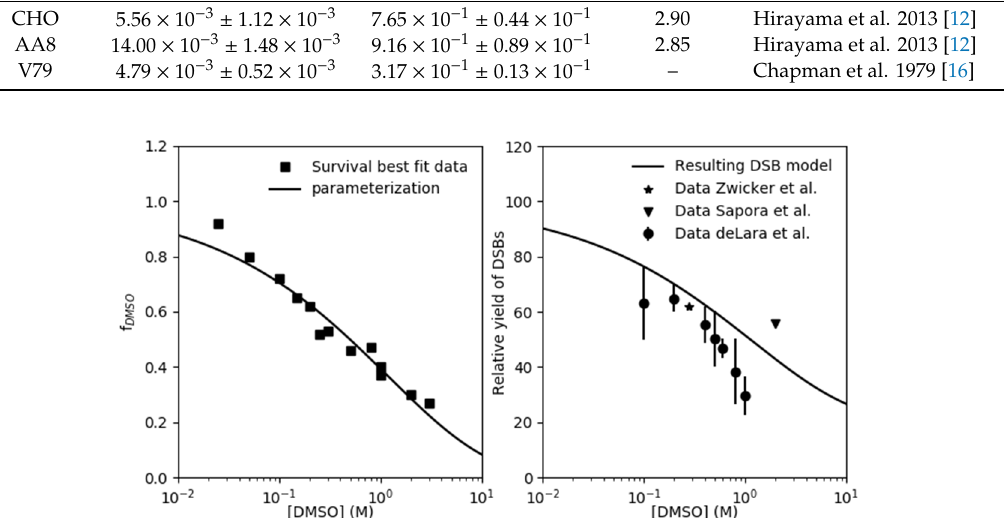
Figure 1. Left panel: f DSMO parameterization as function of DMSO in units of M is depicted with line together with best-fit f DSMO data (squares) obtained by reproducing the cell survival data in normoxia. Right panel: predicted initial normoxic yield of DSBs relative to the yield in absence of DMSO ( R DSB ) calculated using Equation (9) is compared against the experimental data from the literature.